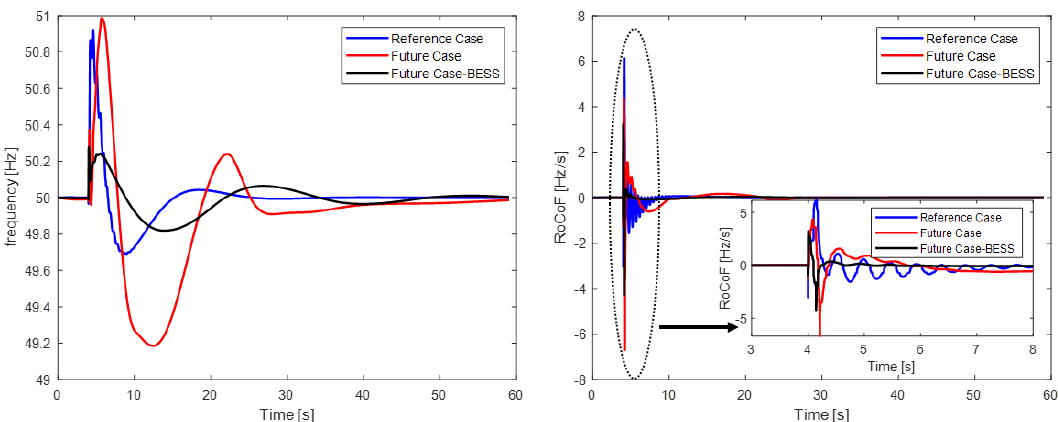
Figure 16. Short-circuit frequency response and RoCoF for the best cases of the reference, future and future with BESS scenarios.